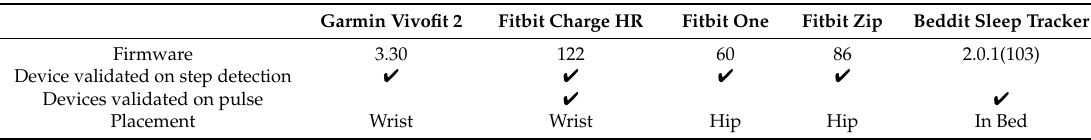
Table 1. Self-monitoring devices tested in this